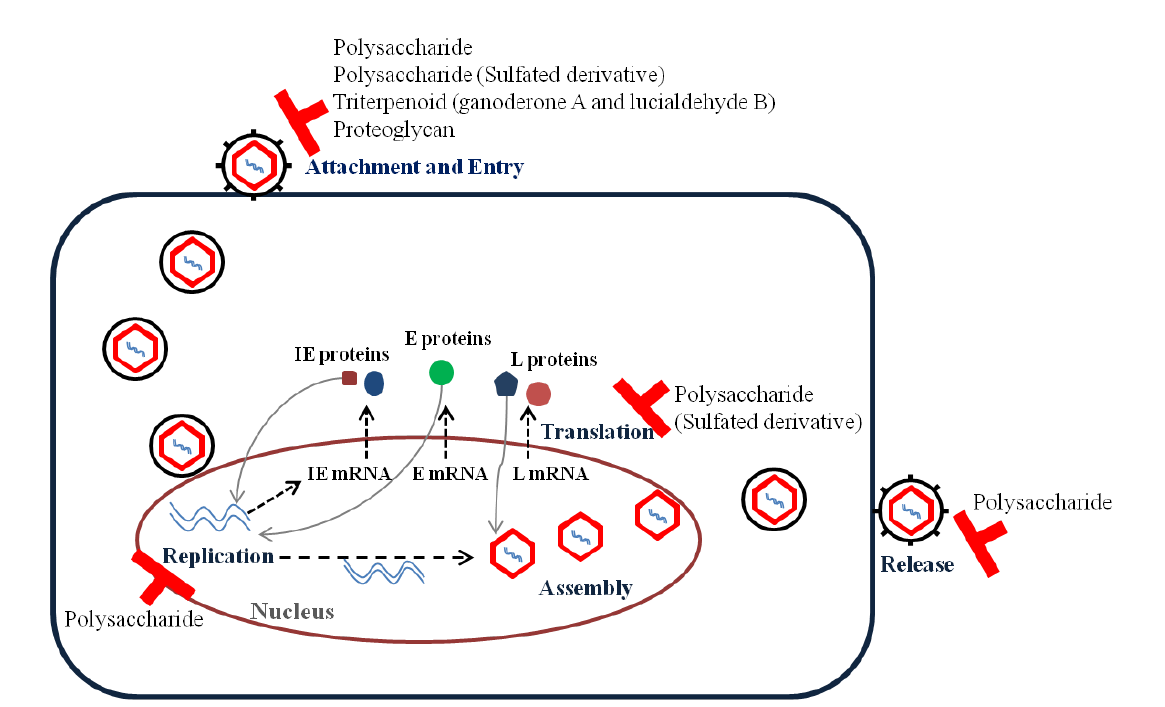
Figure 1. Inhibitory stages of bioactive compounds against herpes simplex virus.